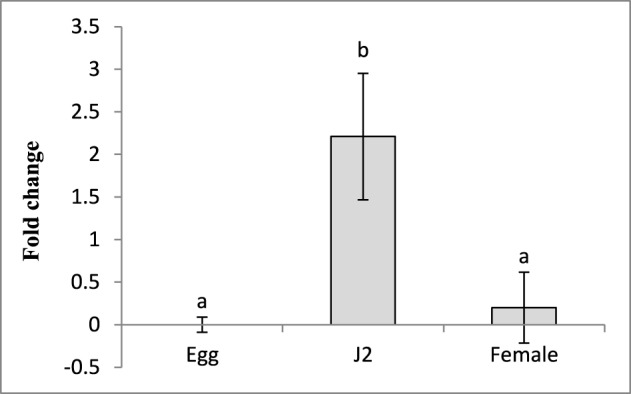
Relative abundance of the transcript of Mi-cpl-1 gene in different developmental stages of M. incognita. Using 2-ΔΔCT method relative expression level was quantified. Using the transcript level of Mi-cpl-1 in eggs as reference, expression of Mi-cpl-1 was found to be significantly higher at J2 stage. Each bar represents the mean ±SE of n = 3, and bars with different letters denote a significant difference at P < 0.05, student's t-test.